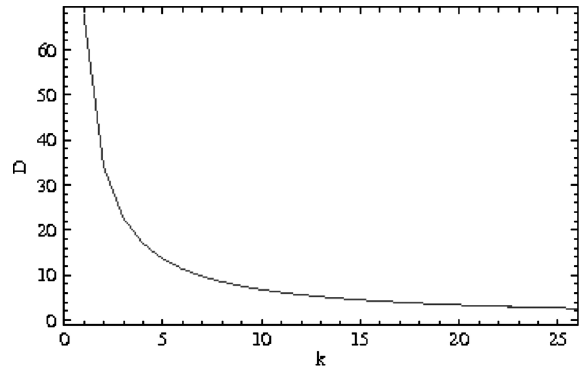
FIG. 52. The dependence of the dispersion in the center of the long drift of a transport cell on the field index k=x